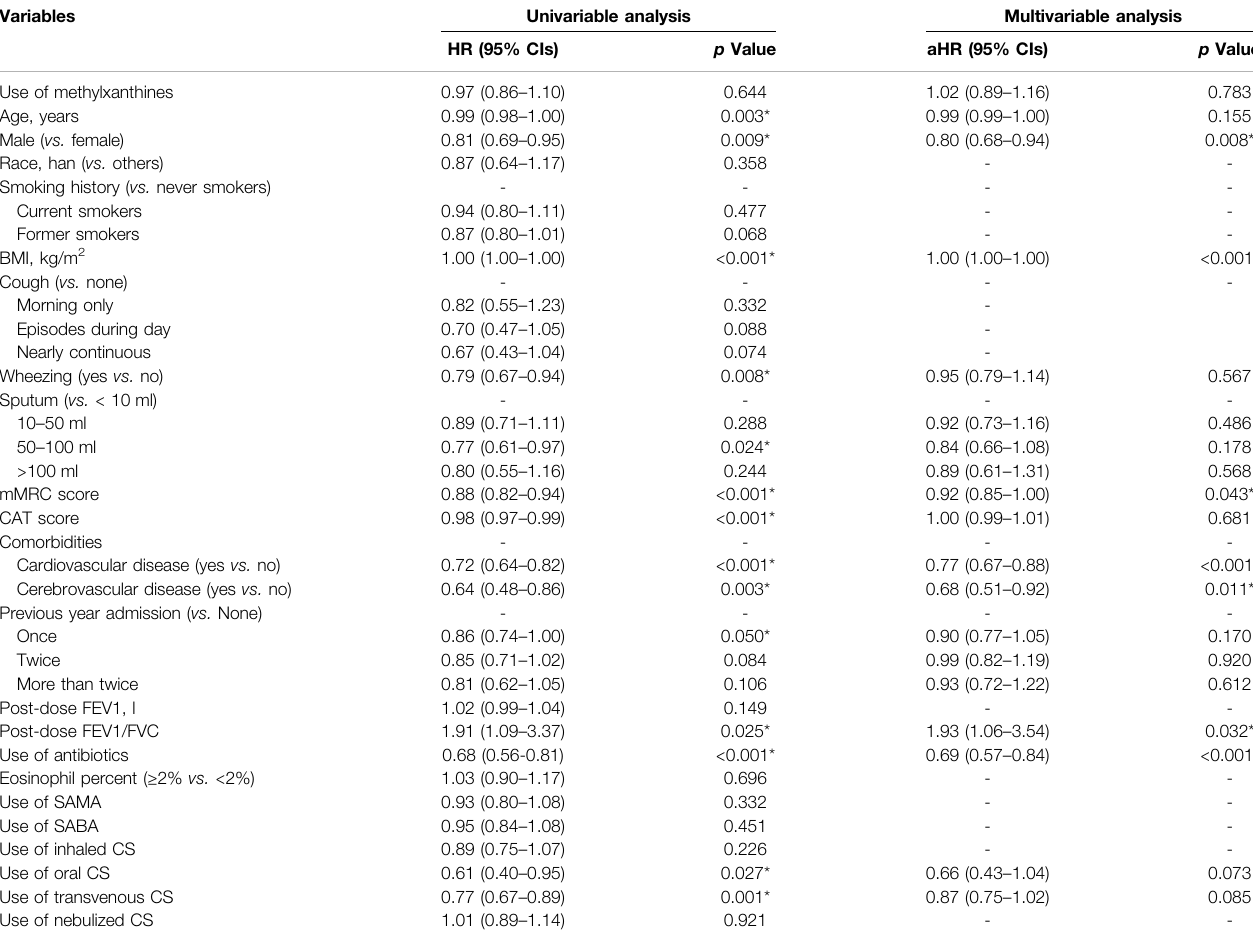
TABLE 4 | Cox proportional hazards regression model for length of stay.